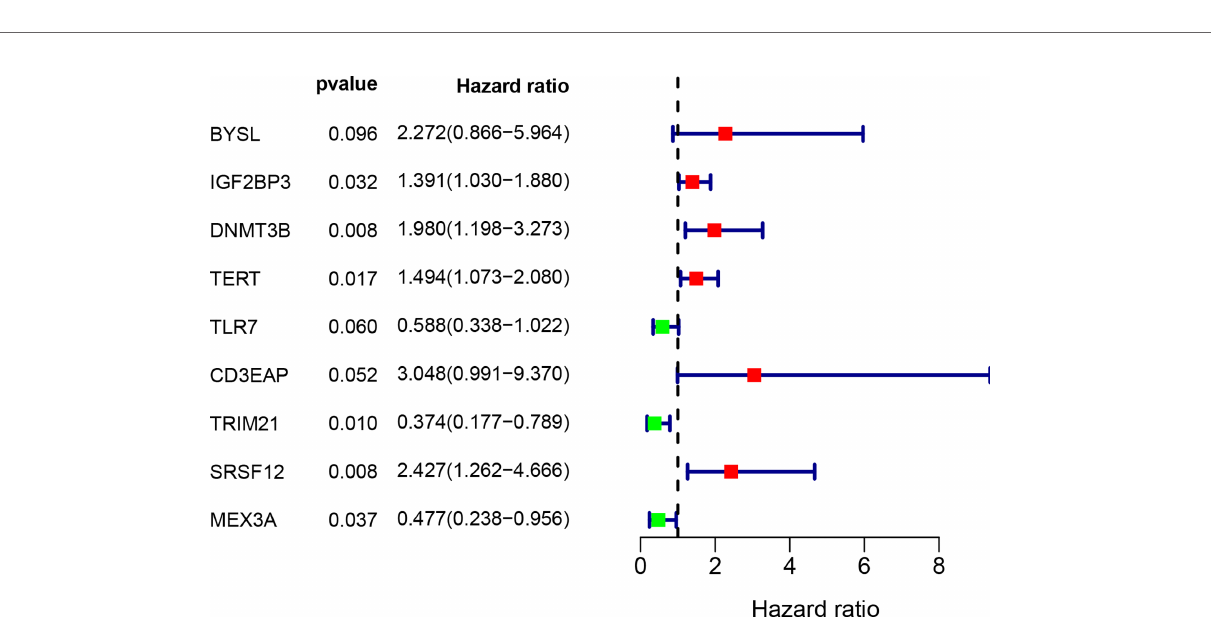
FIGURE 4 | Univariate Cox regression analysis for identi fi cation of survival related RBPs. The forest plot of survival related RBPs based on univariate Cox regression analysis (P < 0.01). Red square, hazard ratio > 1; Green square, hazard ratio < 1.